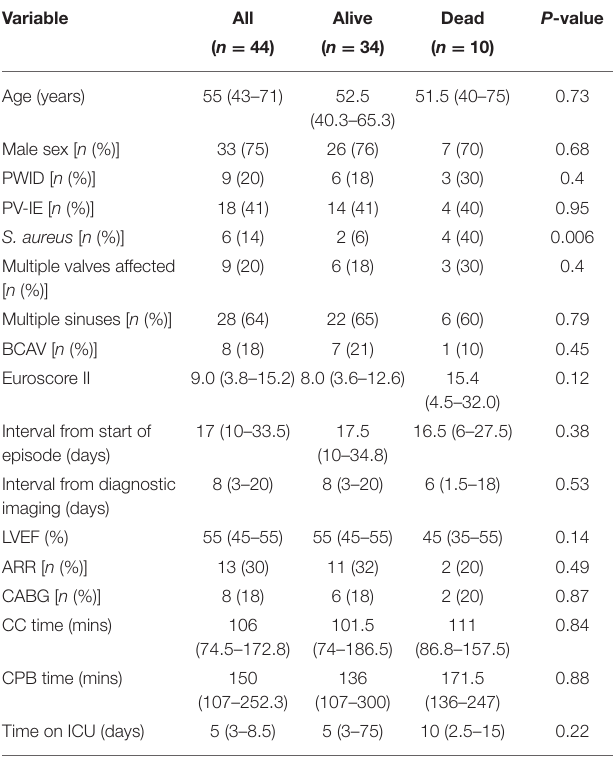
TABLE 3 | Characteristics of operated patients who were alive or dead at 30 days.